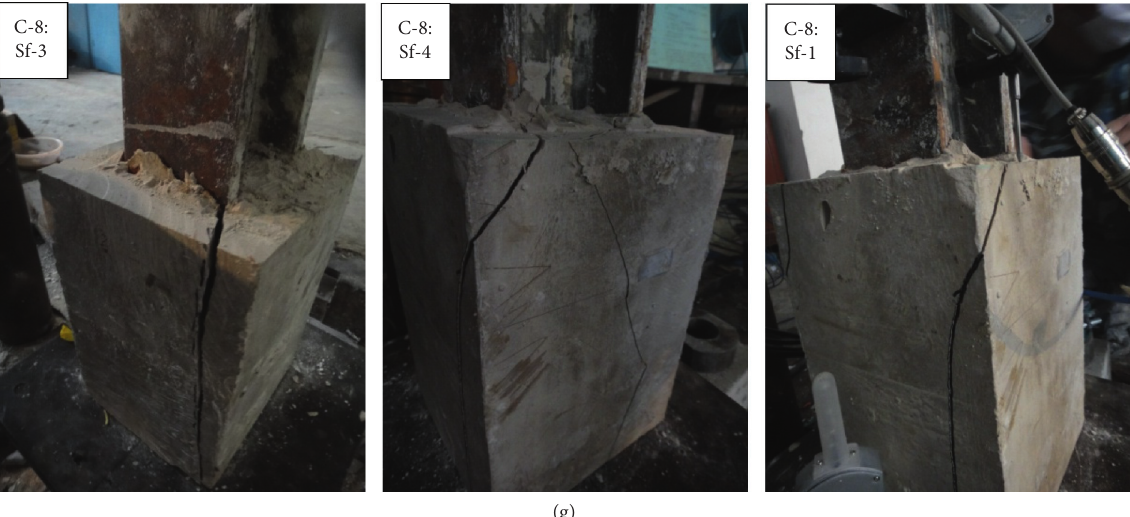
Figure 5: Crack development on vertical surfaces of the gypsum cover. (a) Specimen C-2. (b) Specimen C-3. (c) Specimen C-5. (d) Specimen C-9. (e) Specimen C-6. (f) Specimen C-7. (g) Specimen